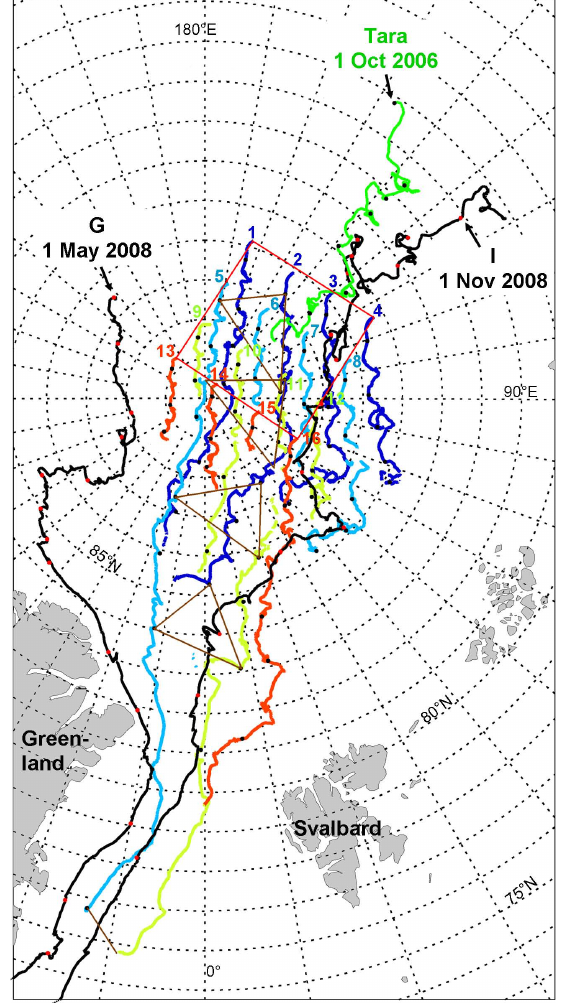
Fig. 4. Drift trajectories of all 16 D07 CALIB buoys, the French sailing vessel Tara (green), and the D08 PAWS buoys G and I (black). Dots in trajectories mark buoy position on first day of each month. Red square surrounds the D07 buoy array at the beginning on 24 April 2007. For a better visualisation of the ice motion the position of the buoy triangle 2-5-11 is given in 2 months intervals on 1 May, 1 July, 1 September, and 1 November 2007.